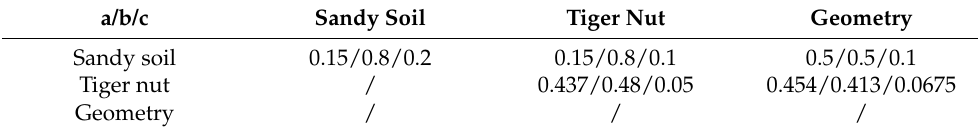
Table 2. Contact Table 2. Contact parameters.